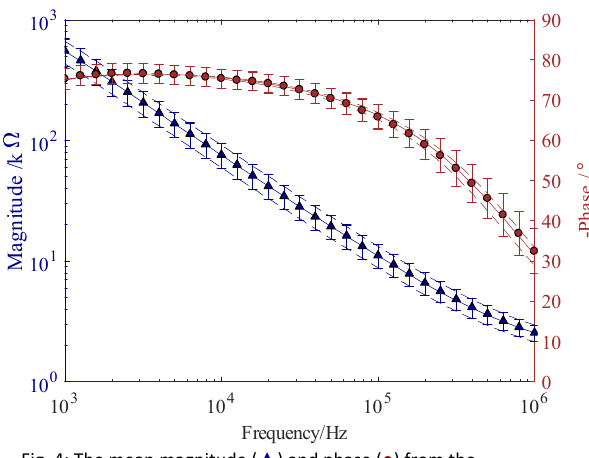
Fig. 4: The mean magnitude ( ▲ ) and phase (●) from the experimental EIS measurements [9] with the error bars indicating one standard deviation. The lines are the predicted counterparts from the approximate semi-analytical solution, where (–) represent a thickness of 14 μm SC and (- -) denotes a thickness of either 11 or 17 μm. These values for the thickness of SC correspond to the mean and ± one standard deviation.